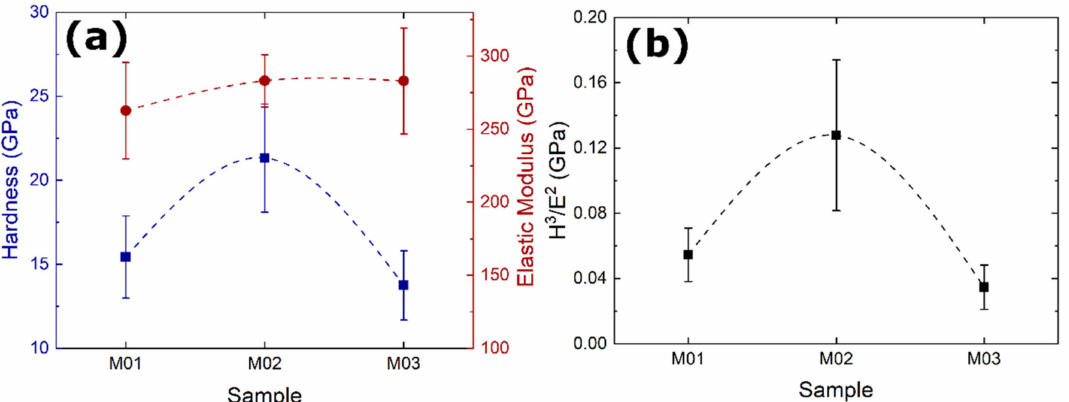
Figure 7. ( a ) The hardness and elastic modulus for each sample showing the maximum hardness for the coating produced with a CrAl target switched to the HiPIMS power supply (M02) and ( b ) calculated H 3 /E 2 ratio for all three samples, showing the highest ratio for